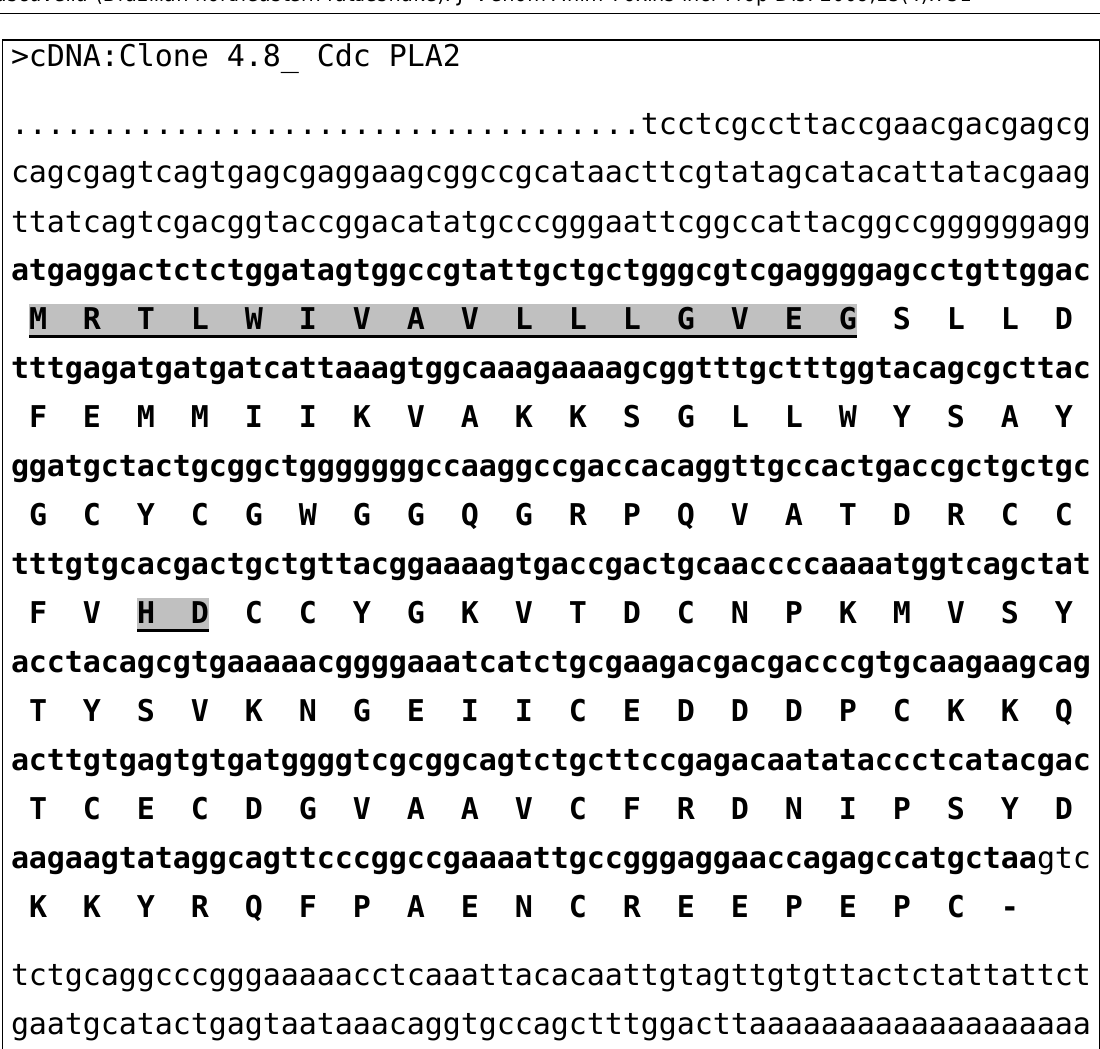
precursor from the 2 cDNA precursor (accession 2